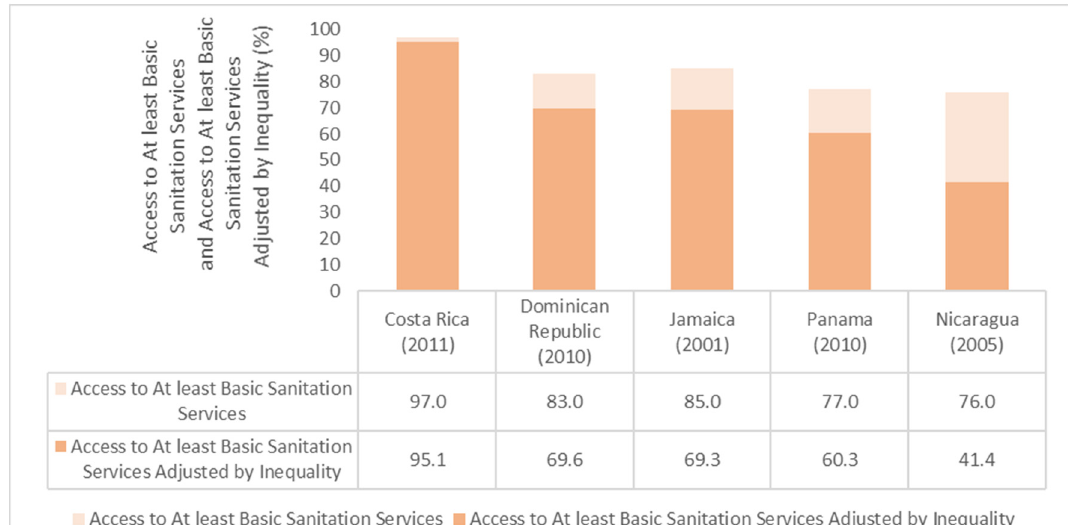
Figure 6. Access to at least basic sanitation services and access to at least basic sanitation services adjusted for inequality. Source: Own elaboration based on census microdata from the IPUMS- International Project [25].